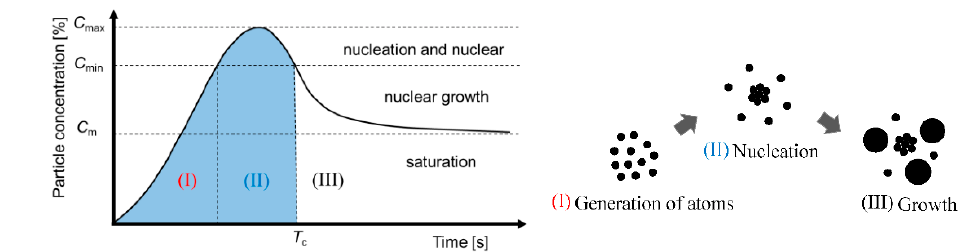
Figure 1. LaMer diagram. T c is a critical mixing time for preparation of monodisperse